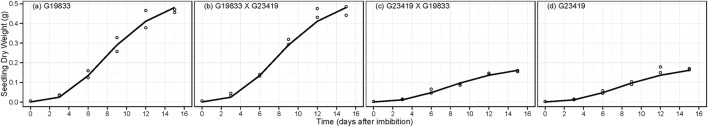
Fitted Gompertz growth equation for seedling dry weight accumulation (SDLDW, g) over time for parental genotype (A) G19833, the reciprocal F1 hybrids (B) (G19833 × G23419) and (C) (G23419 × G19833), and parental genotype (D) G23419.